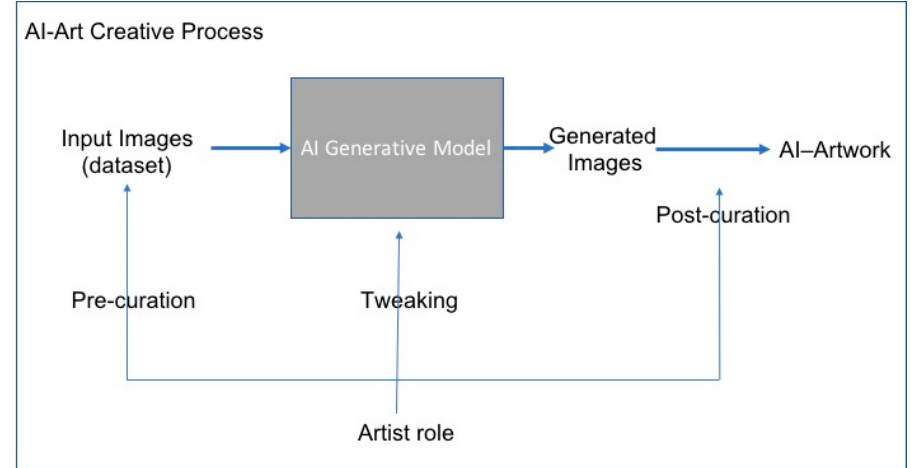
Figure 1. A block diagram showing the artist’s role using the AI generative model in making art. Diagram created by author A. Elgammal.